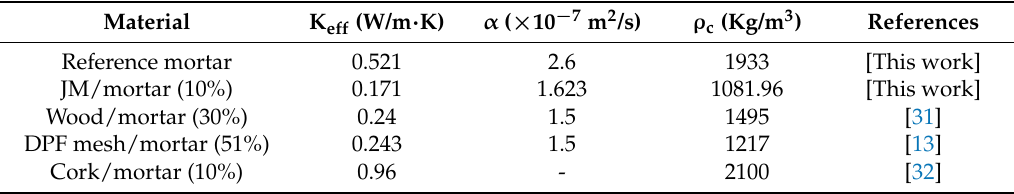
Table 5. Comparison of the thermal properties of Juncus maritimus/mortar composites and some building materials used for thermal insulation. DPF: date palm